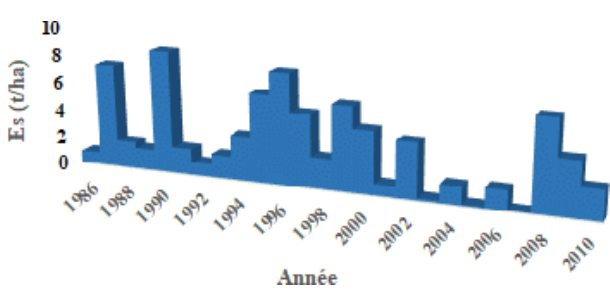
Figure 2. Dégradation spécifique dans le bassin de l’Oued